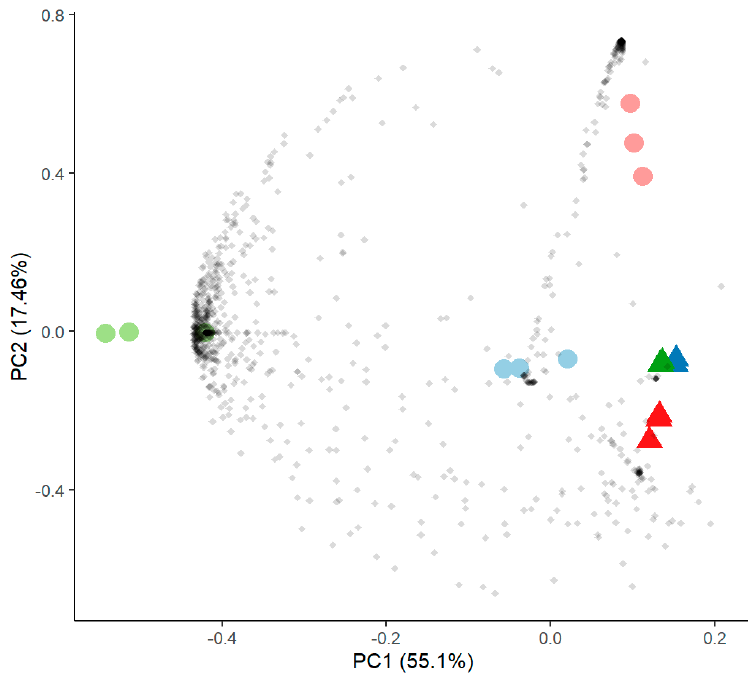
Figure 6. Principal component analysis of proteome data comparing samples without (round symbols) and with SrCl 2 (triangles) of Aspergillus sp. SFB31 (blue), SFB 32 (green) and SFB 84 (red).